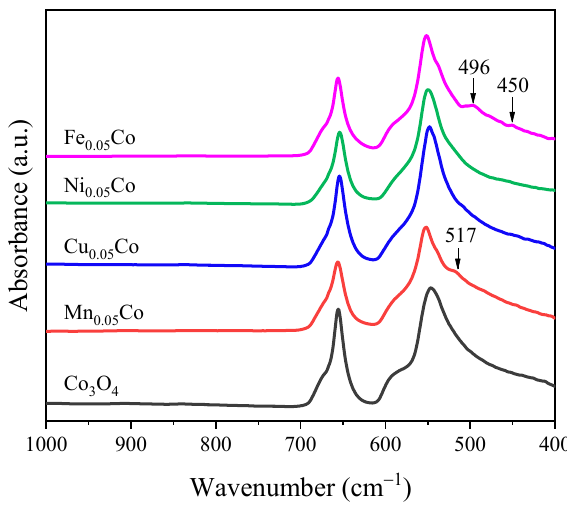
Figure 2. FTIR spectra of the Co 3 O 4 and M 0.05 Co catalysts.